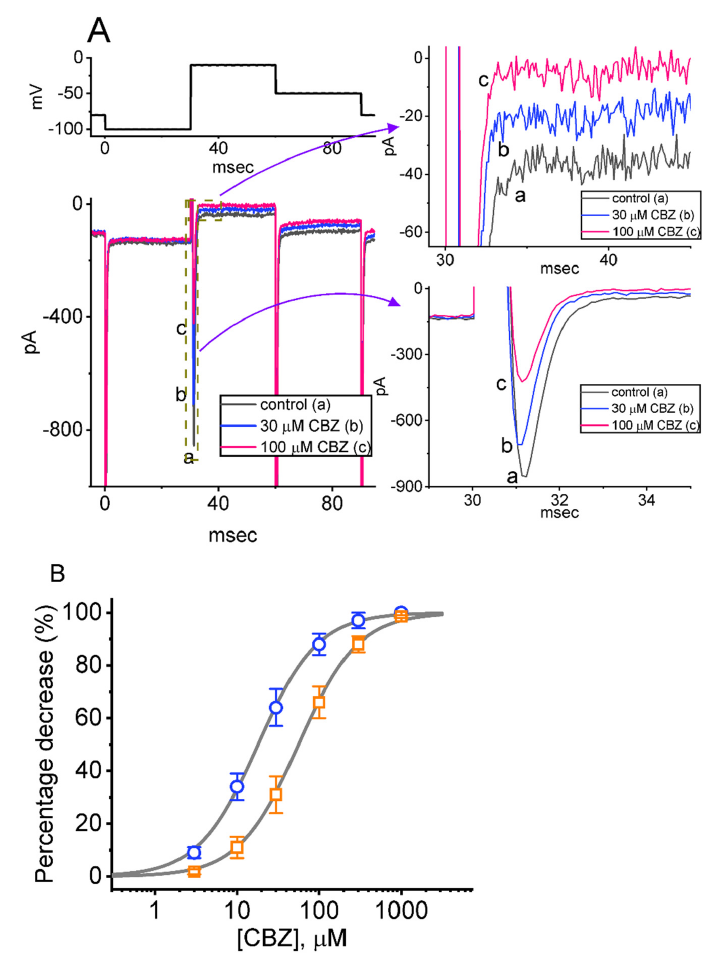
Figure 1. Effect of carbamazepine (CBZ) on voltage-gated Na + current ( I Na ) residing in Neuro-2a cells. In this set of measurements, we bathed cells in Ca 2+ -free Tyrode’s solution containing 10 mM tetraethylammonium chloride (TEA) and 0.5 mM CdCl 2 , while the electrode that was used was filled up with an internal solution containing Cs + . ( A ) Representative current traces were acquired in the control period (a) (i.e., CBZ was not present) and during cell exposure to 30 μ M CBZ (b) or 100 μ M CBZ (c). The upper part indicates the voltage clamp protocol that we applied. The graphs demonstrated on the right side of ( A ) denote the expanded records from the left side (broken boxes). ( B ) Concentration–responses curve of CBZ-induced inhibition of peak (transient) I Na ( I Na(T) ) or sustained (late) I Na ( I Na(L) ) identified in Neuro-2a cells (mean ± SEM; n = 8–9). The sigmoidal curves drawn represent the goodness-of-fit of the modified Hill equation, as described in Section 4. The IC 50 values needed for CBZ-mediated inhibition of I Na(T) (open orange squares) and I Na(L) (open blue circles) were properly estimated to be 56 and 18 µ M, respectively. Data analysis was performed by one-way ANOVA (F = 4.7, p <